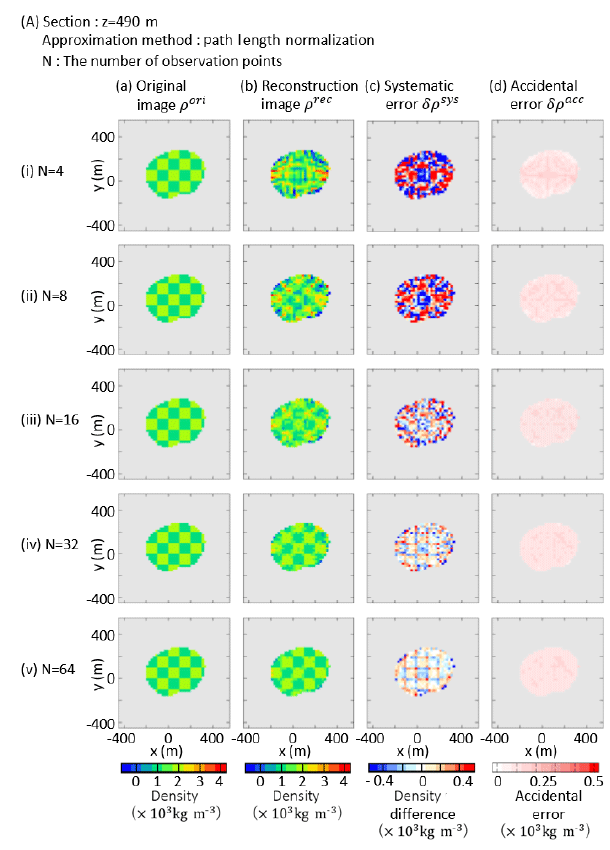
Figure 8. (A). Reconstruction results on a z = 490m cross section. (a) Original image: ρ ori (x,y,z) ; (b) reconstruction image: ρ rec (x,y,z) ; (c) systematic error: δρ sys (x,y,z) ; (d) acci- dental error: δρ acc (x,y,z) .